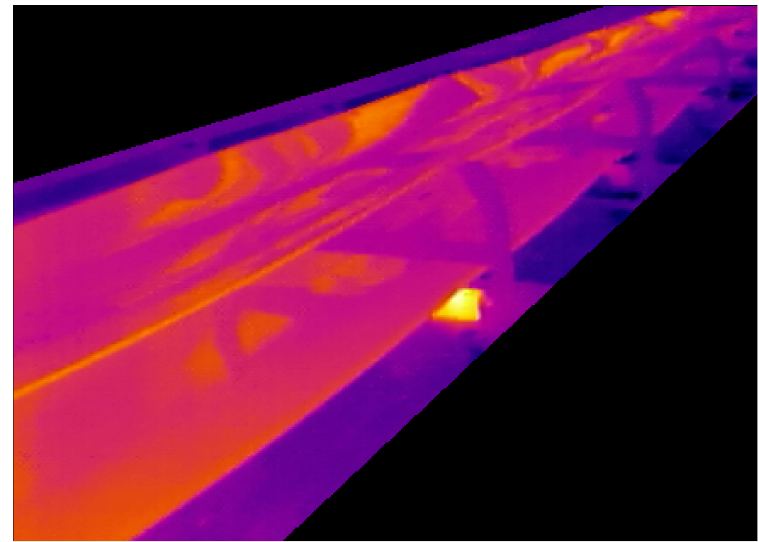
Figure 11. Frame narrowed to the main line with applied